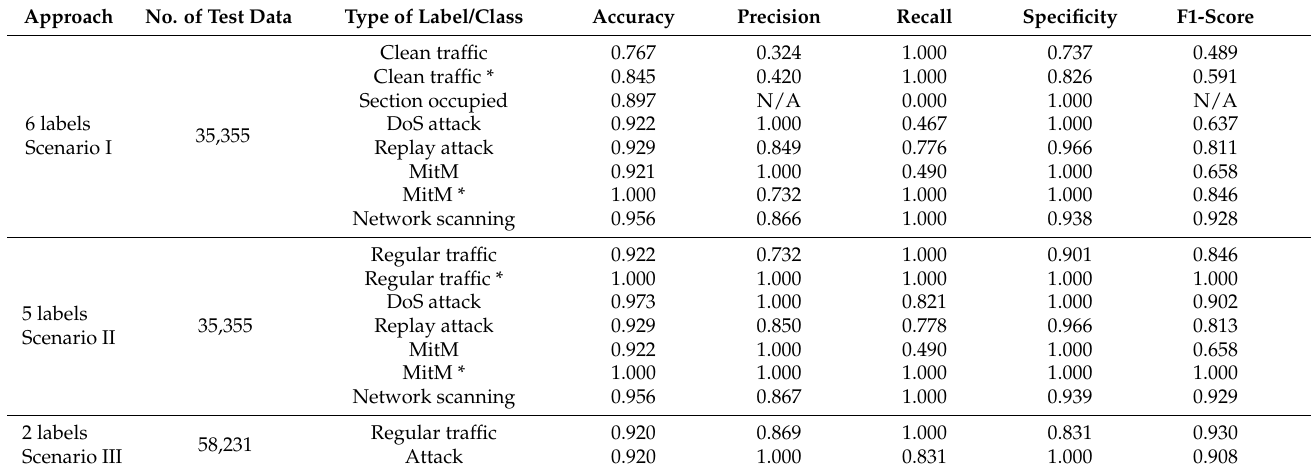
Table 3. Comparison of achieved results using